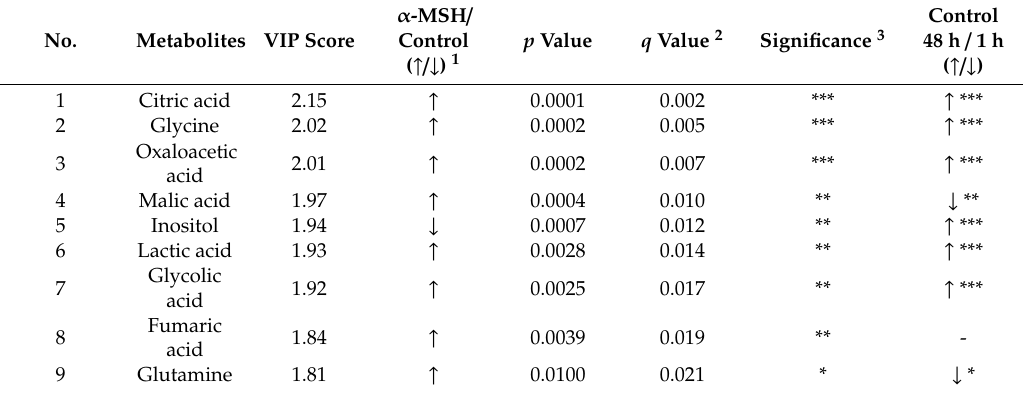
1 The vertical arrows ( ↓ and ↑ ) represent a decrease or increase in metabolite levels after 48 h of incubation. 2 False discovery rate (FDR). The false discovery rate at 5% was applied to all tests to correct for multiple testing. 3 Symbols (*) indicate significant di ff erence (* p < 0.05; ** p < 0.01; *** p <